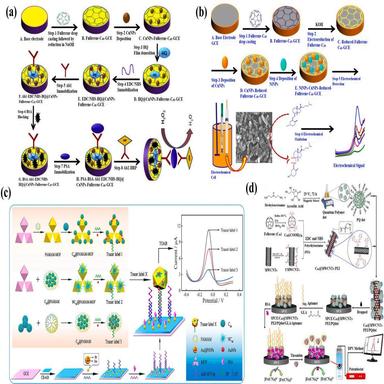
Schematics of the following procedures: (a) the construction of an immunosensing platform and the sensing mechanism of prostate specific antigen (PSA), Reproduced with permission; (b) the construction of sensing platform for the determination of vitamin D3 in a blood sample; Reproduced with permission (c) the development of three tracer labels and the fabrication of an miRNA biosensor for the sensing of miR-3675-3p, Reproduced with permission; and (d) the preparatio